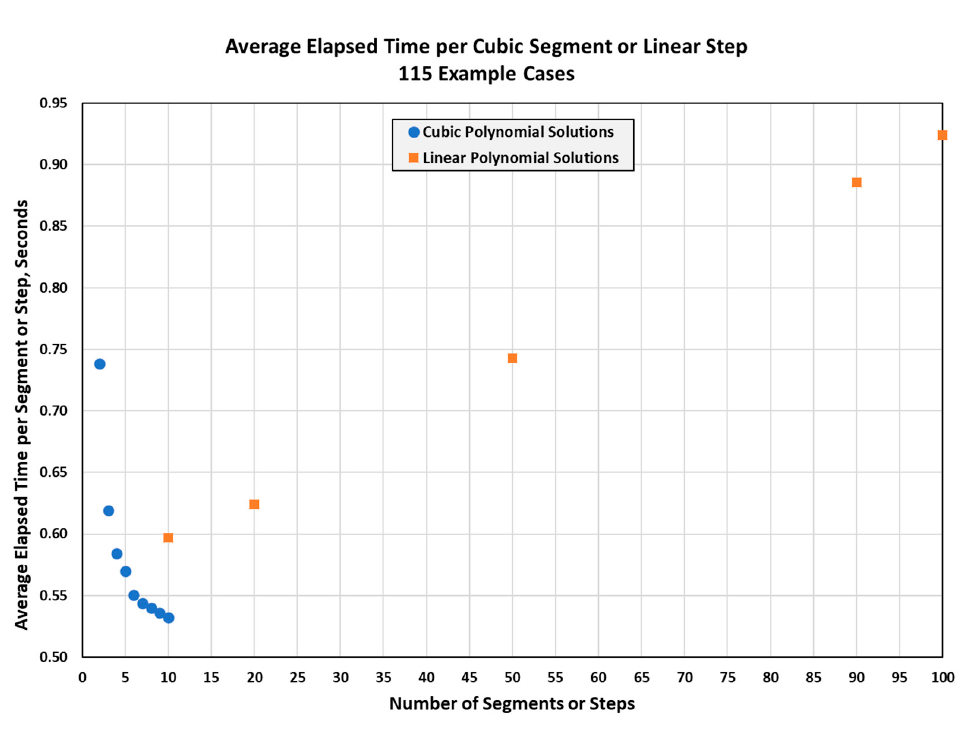
Figure A9. Average elapsed calculation time per cubic segment and linear step for 115 example cases.